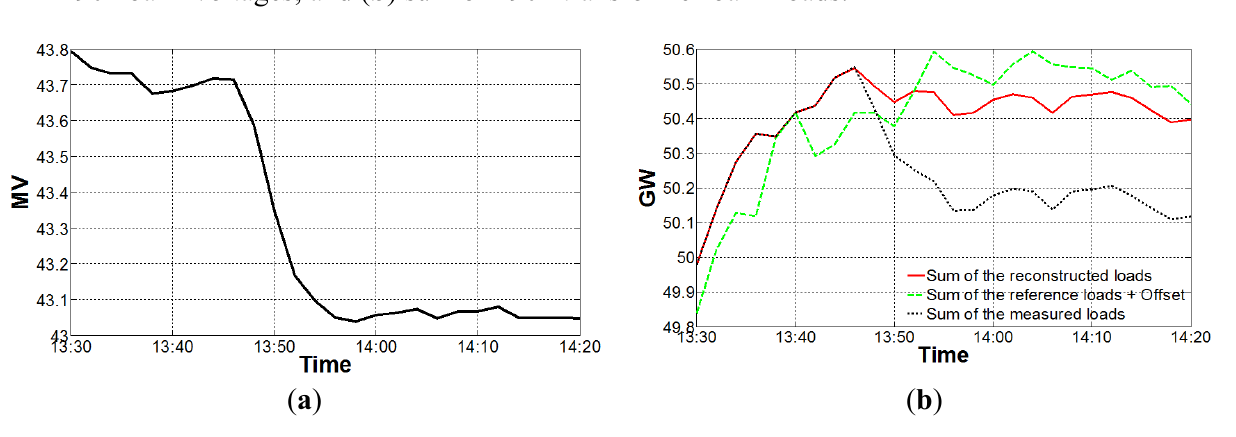
Figure 5. Results of the nationwide CVR implemented on 9 August 2012: ( a ) sum of 1901 bank voltages; and ( b ) sum of 1901 transformer-bank